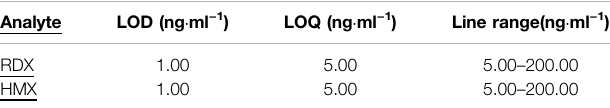
TABLE 2 | LODs, LOQs and line ranges for determination of RDX and HMX in rat plasma.